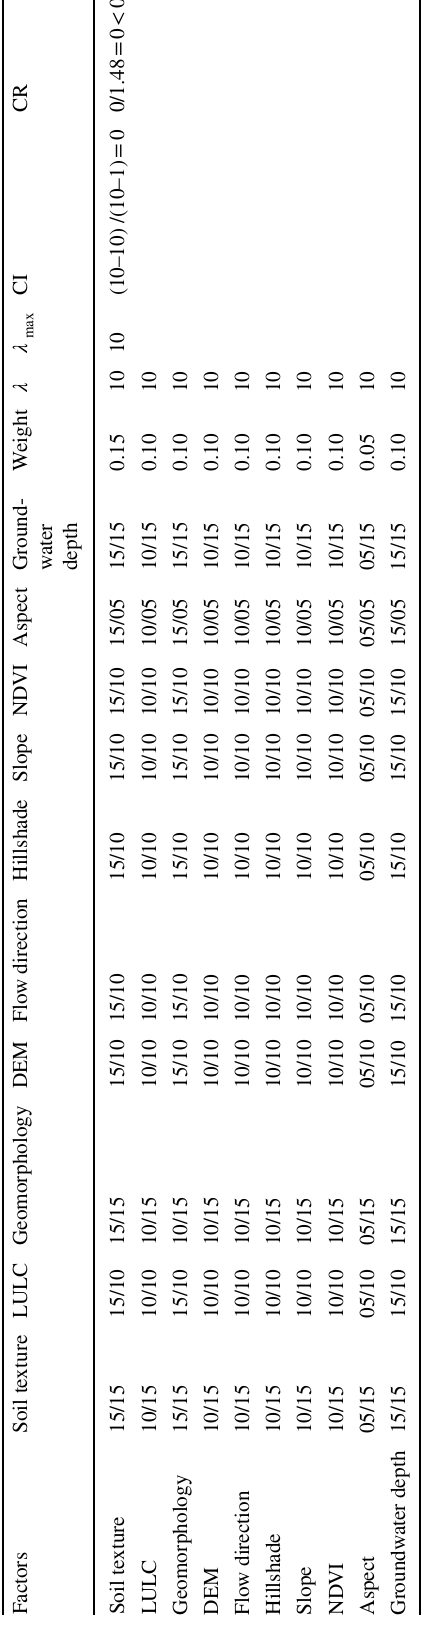
Table 4 Assigned weight ranks and overall of the sub-classes of